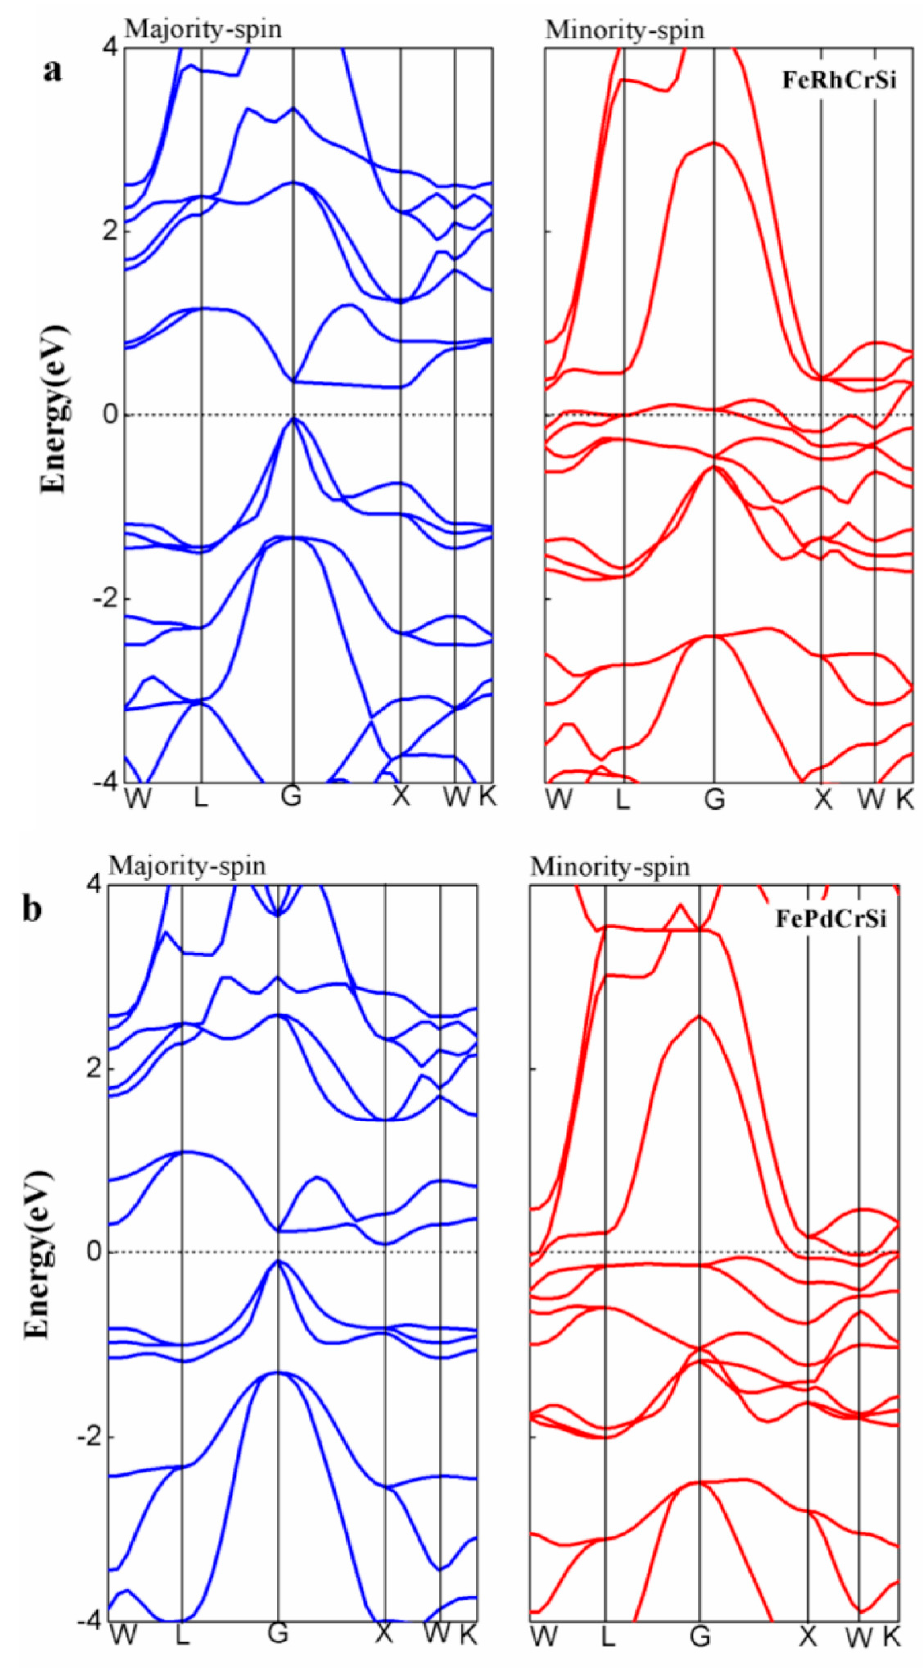
Figure 4. The band structures of ( a ) FeRhCrSi and ( b ) FePdCrSi at their equilibrium lattice constants.